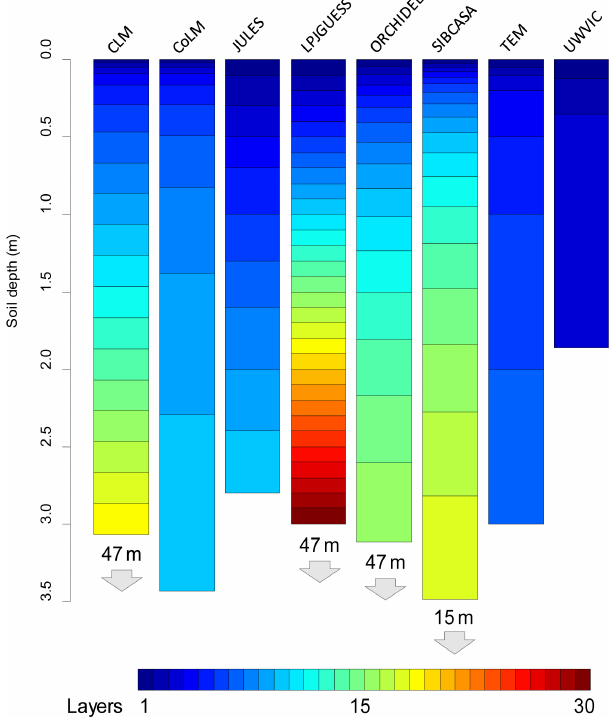
Figure 1. Soil hydrologically active column configuration for each participating model. Numbers and arrows indicate full soil configu- ration of nonhydrologically active bedrock layers. Colors represent the number of